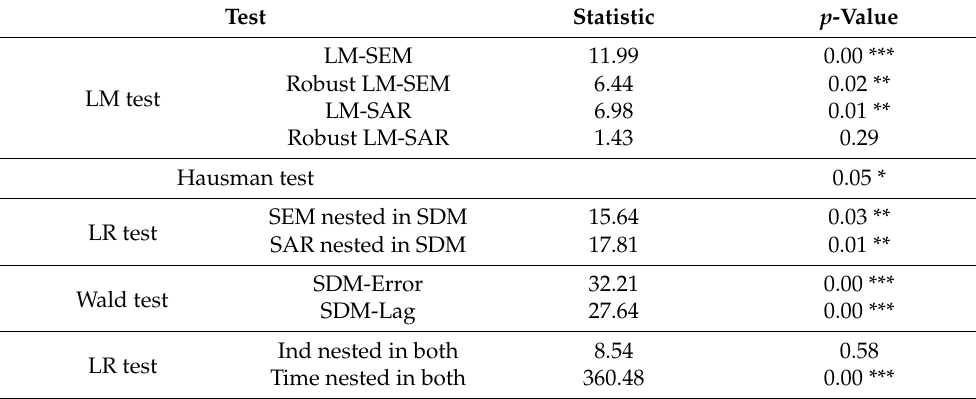
Table 6. Results of the basic test of the spatial econometric model.